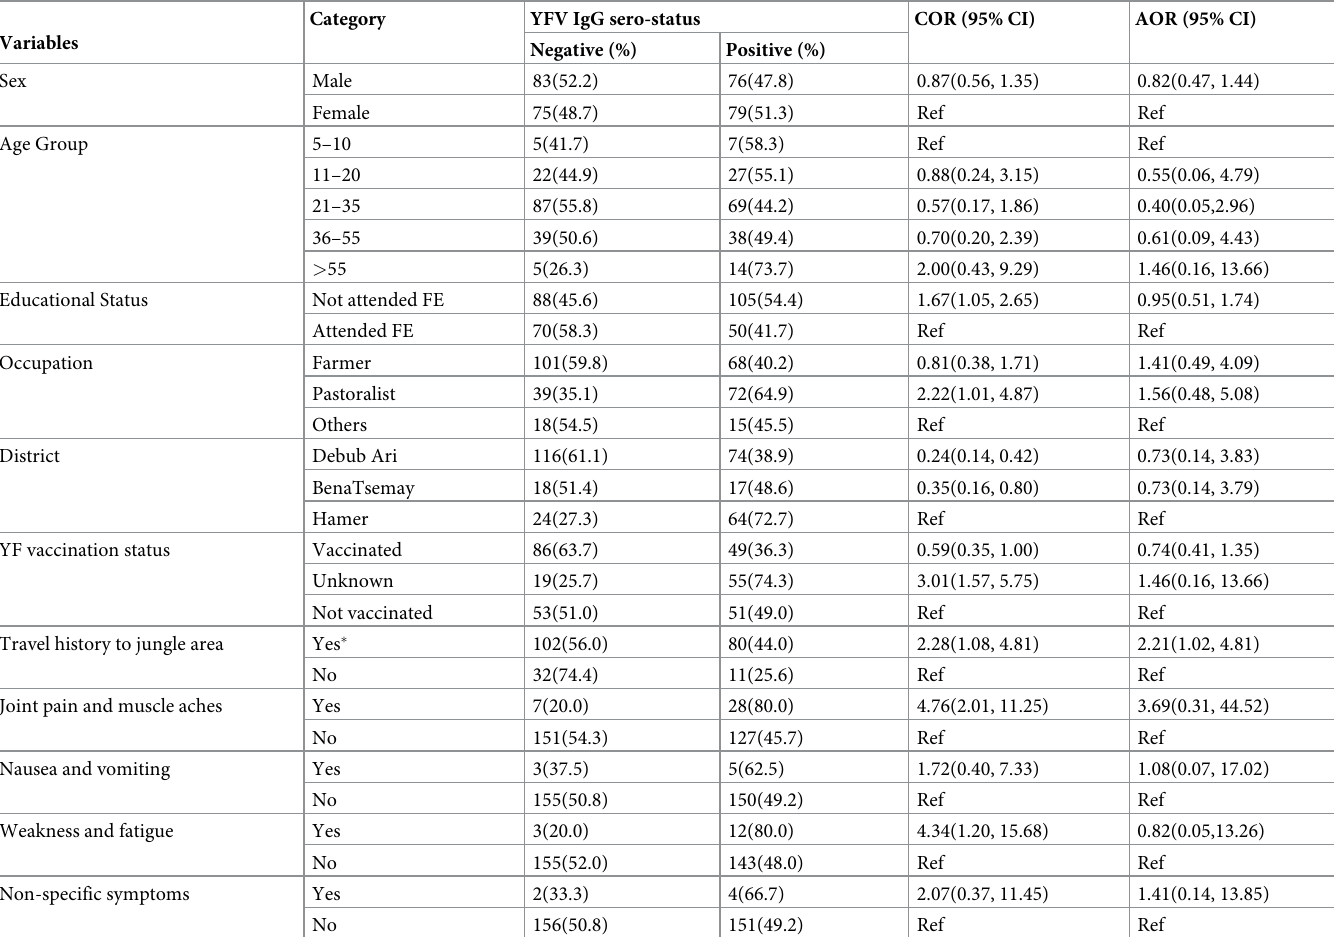
Table 4. Sero-positivity for IgG antibody to YFV and associated factors in the study participants (N = 313).